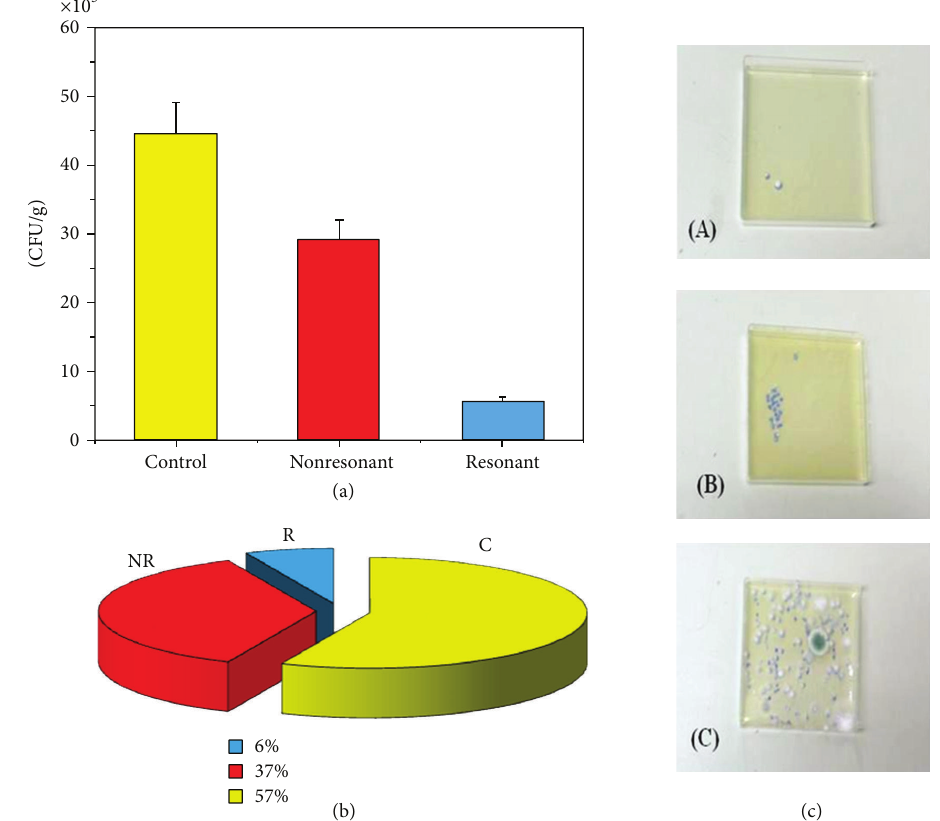
F 3: (a) and (b) average colony forming units per gram (CFU/g) expressed in bars diagram (a), and cheese percentage (b) for (R),